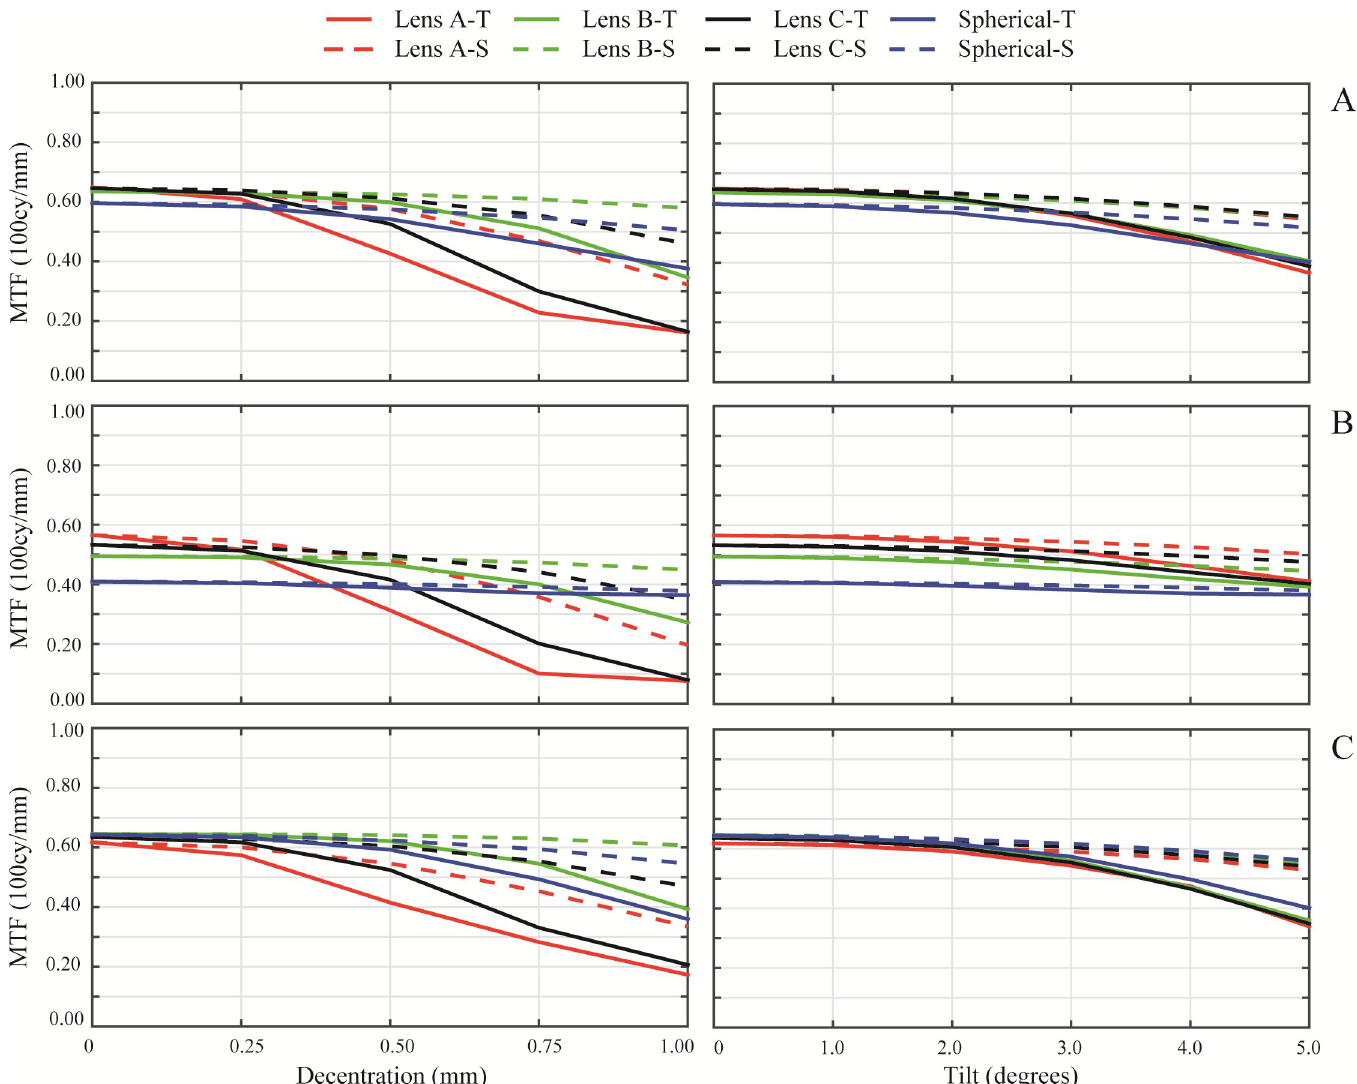
Fig 1. The on -axis MTF of the designed IOLs as a function of misalignment (left column) and tilt (right column) with a 3.00 mm pupil diameter and 100 cycles per degree with different corneas. The tangential MTF (continuous line) and the sagittal MTF (dashed line) are shown for each cornea: A) Navarro’s eye model cornea, B) Myopic cornea, C) Hyperopic